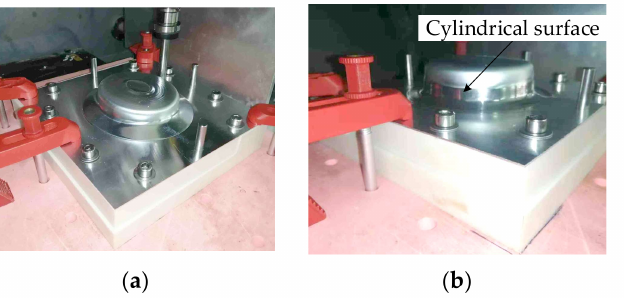
Figure 30. The proposed forming method: ( a ) the third-stage forming process; ( b ) the part formed by the third-stage